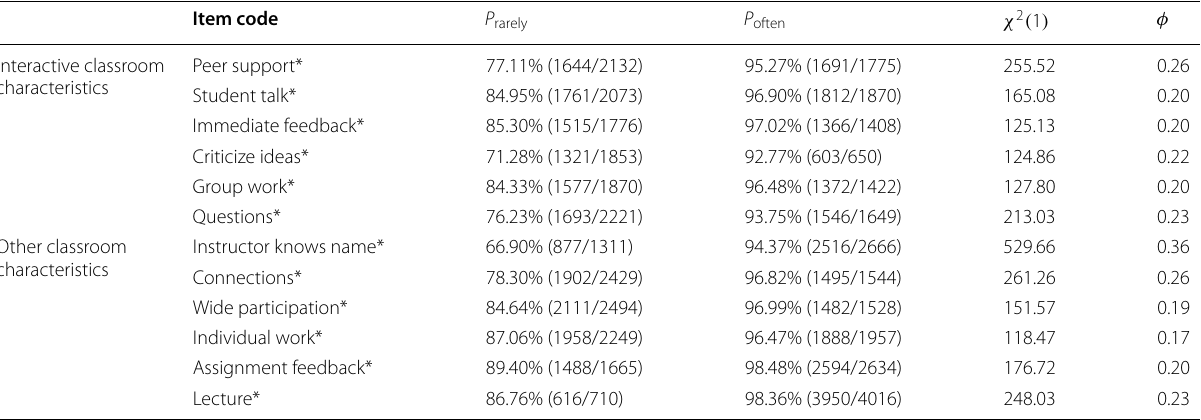
2 Chi-square tests ×